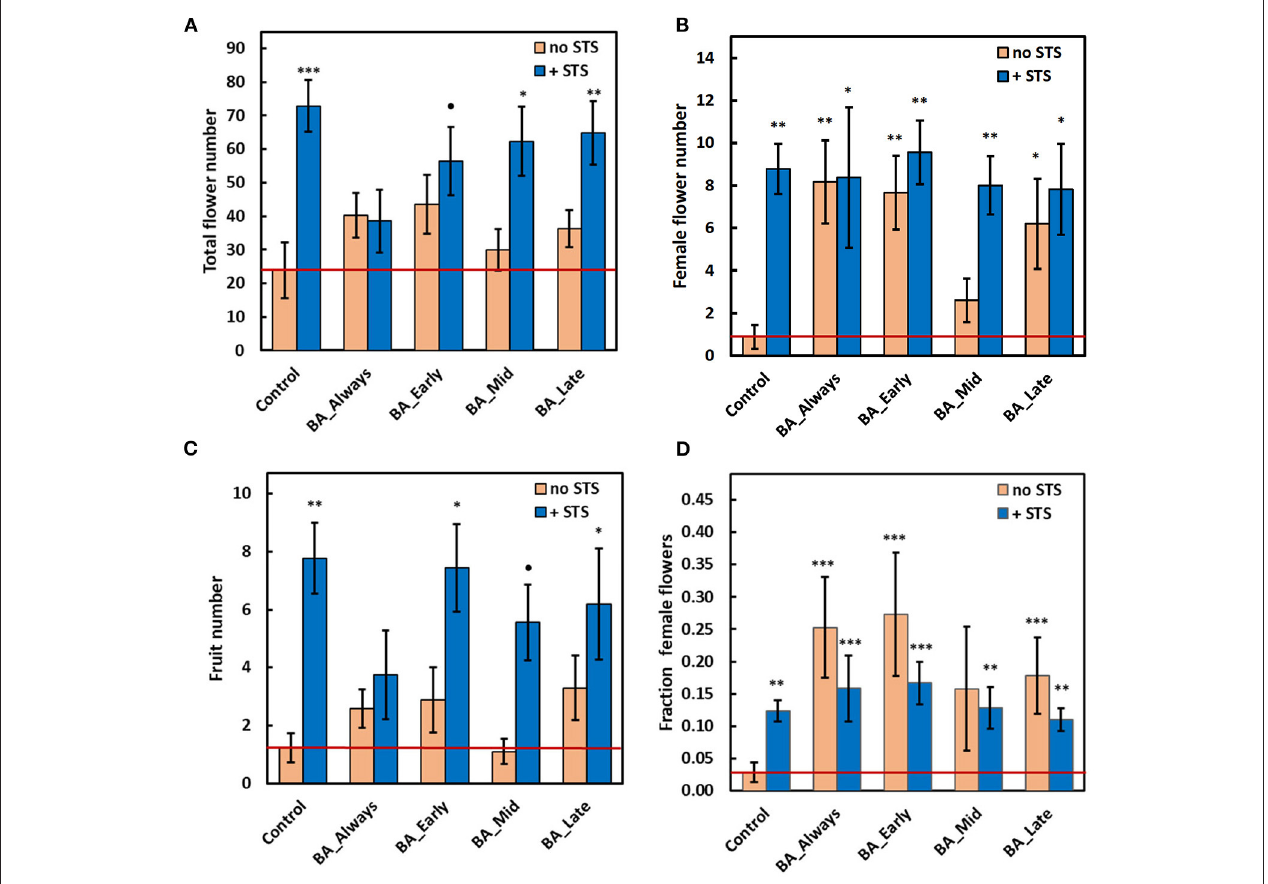
FIGURE 2 | Effect of STS and BA treatments on: (A) total flower numbers per plant, (B) number of female flowers per plant, (C) number of fruit per plant, and (D) fraction of female flowers. STS vs. no-STS (H 2 O) treatment is indicated by bar color as shown in the legends. BA treatments were applied throughout floral development (BA Always), or they were initiated at three timings (BA Early, BA Mid, or BA Late). The study was conducted using genotype TMS-I980002 in the field at Ibadan, Nigeria in 2017. See Materials & Methods section for details. Data shown is the mean and SEM of 10 biological replicates; asterisk indicates statistical significance in pairwise comparisons between each treatment and the reference control (no BA, no STS): P ≤ 0.10 ( • ), P ≤ 0.05 (*), P ≤ 0.01 (**), P ≤ 0.001 (***). The value for the reference control is shown as a horizontal red line. STS, silver thiosulfate; BA,